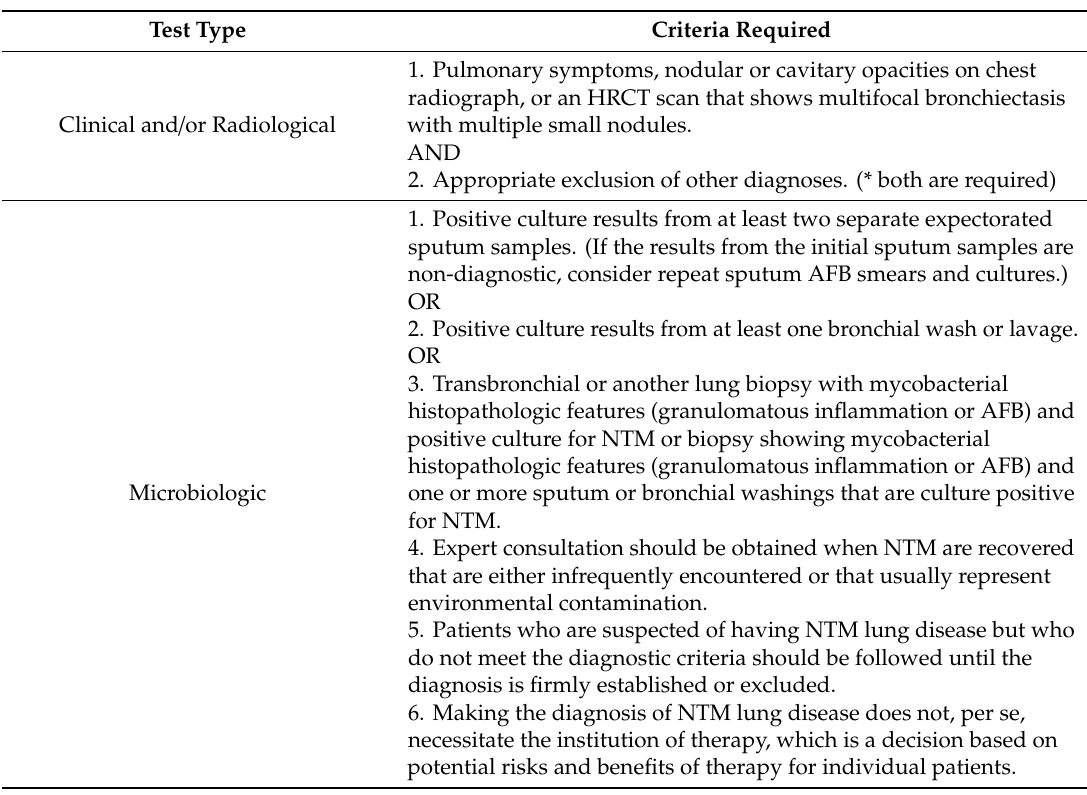
Table 3. Radiological and microbiologic criteria for nontuberculous mycobacteria (NTM) lung disease